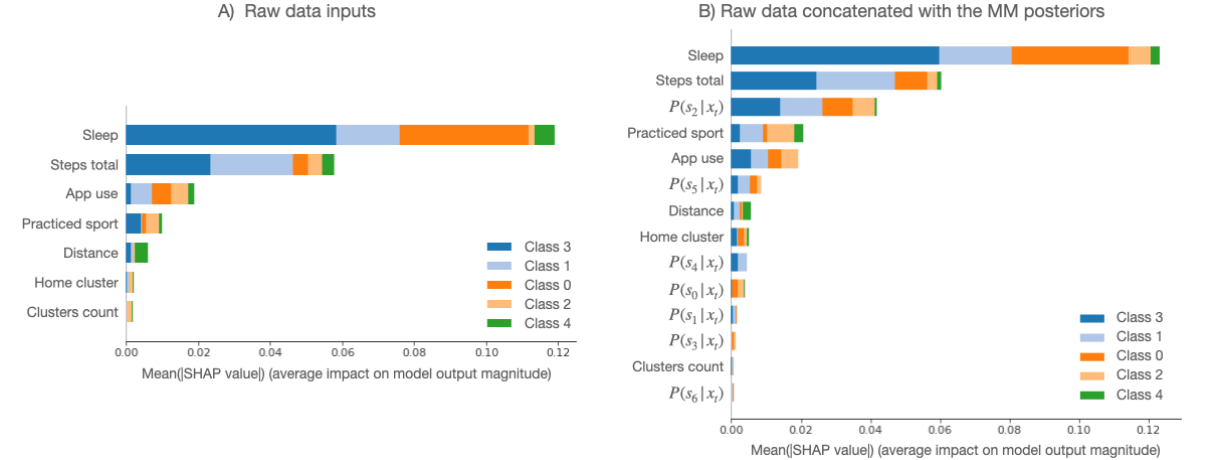
Figure 5. Summary plot of feature importance for the random forest models for emotional arousal-valence prediction, showing raw data and raw data concatenated with mixture model posteriors. In terms of features, "steps total" refers to step count, "distance" refers to the distance traveled, "sleep" refers to the hours of sleep, "app use" refers to the hours spent using different apps, "home cluster" refers to the time spent at home, "clusters count" refers to the number of visited locations, "practiced sport" is an indicator of whether the patient practiced any sports, and " P ( s i | x t )" represents the posterior probability in component i . The following class labels were used: 0=neutral; 1=high arousal-positive valence; 2=high arousal-negative valence; 3=low arousal-negative valence; and 4=low arousal-positive valence. MM: mixture model; SHAP: Shapley additive